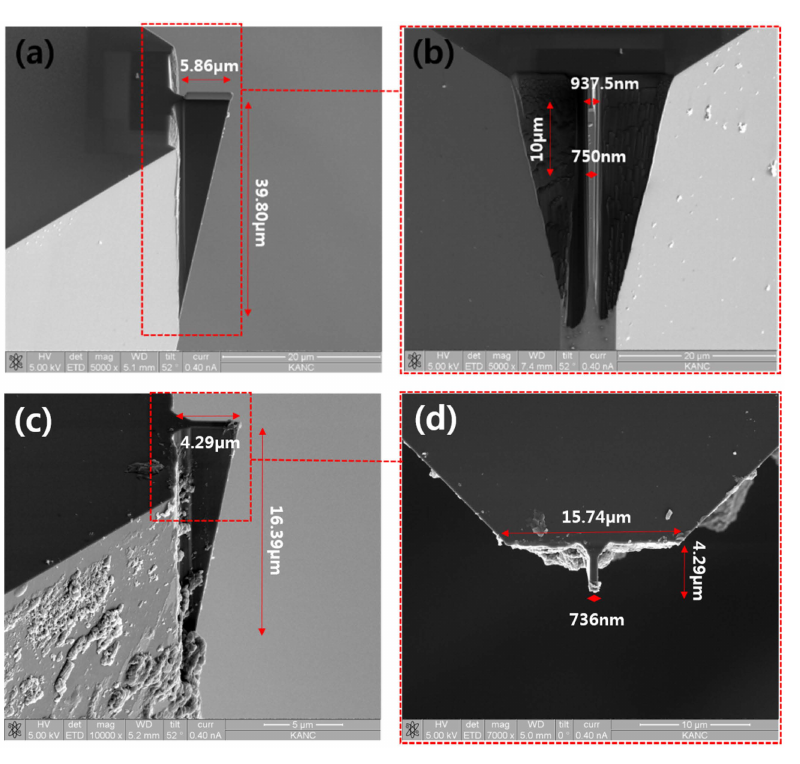
Figure 6. SEM images of 700nm level FIB diamond cutting tool ( a , b ) before removing Pt coating layer with ultra-precision grinding; ( c , d ) after removing Pt coating layer with ultra-precision